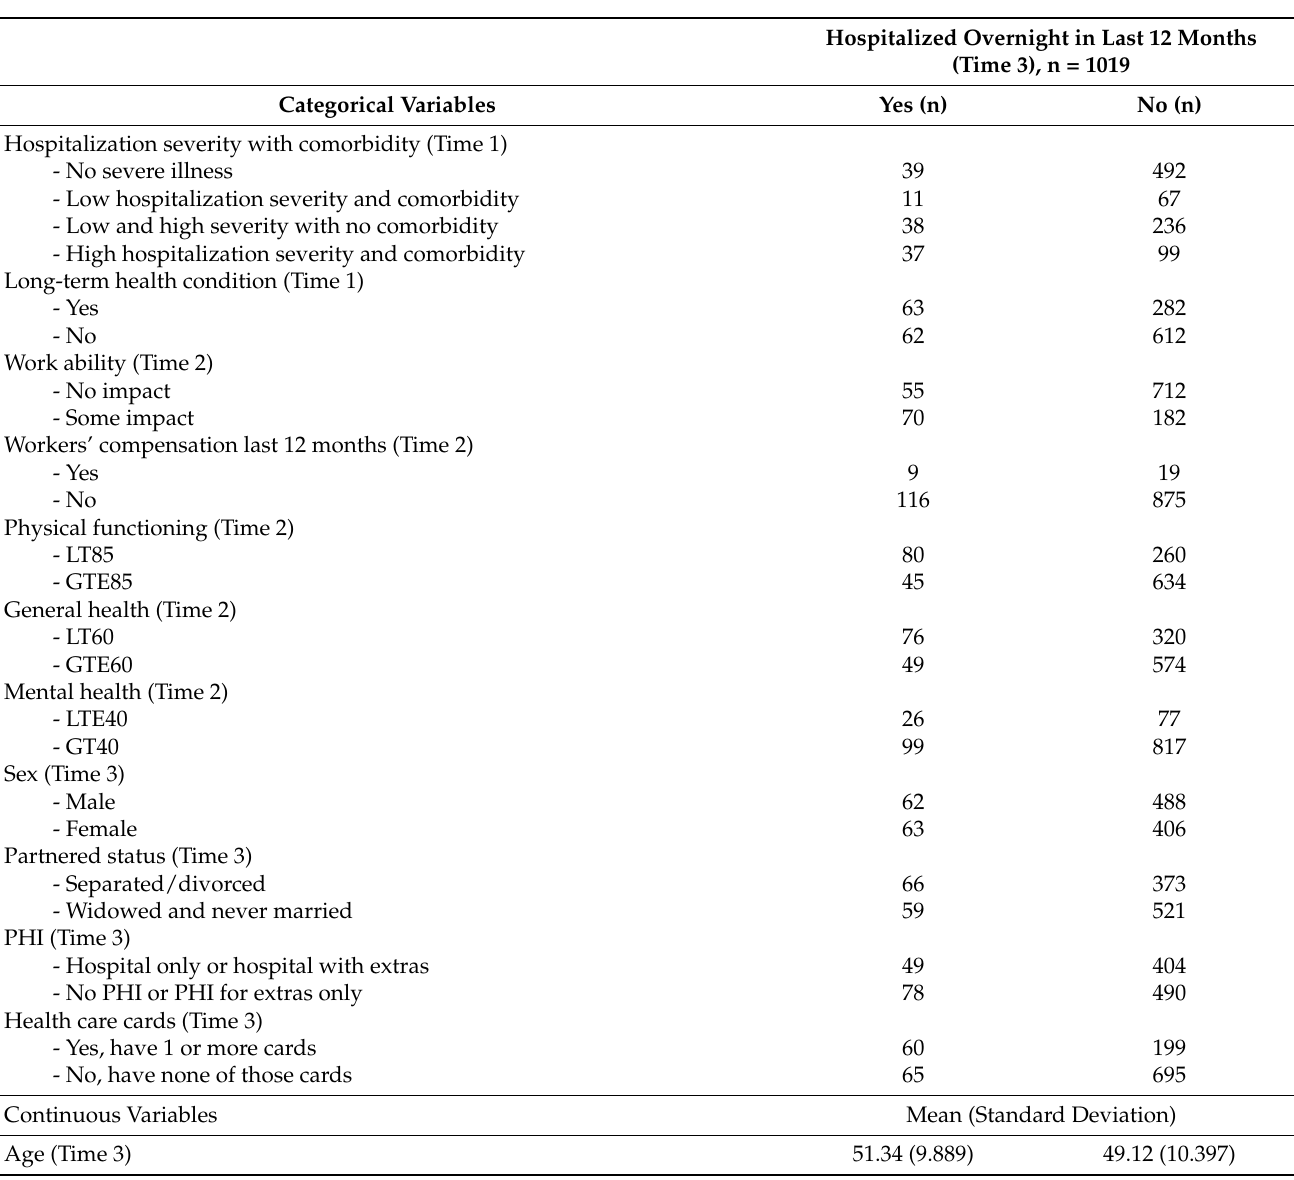
Table 1. The variables in the analyses by hospitalization status at time 3.